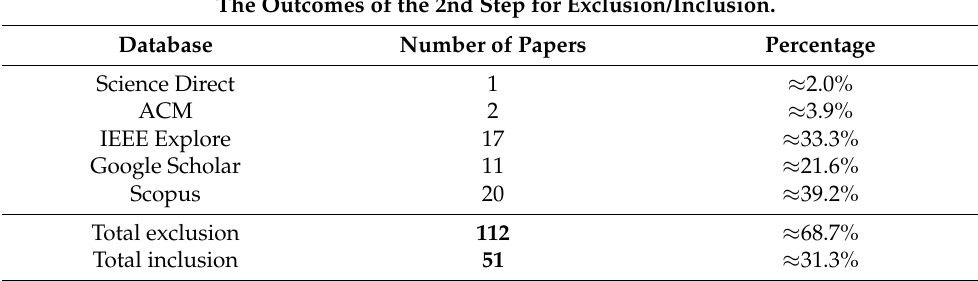
Table 7. The outcomes of the 2nd step for exclusion/inclusion. The Outcomes of the 2nd Step for